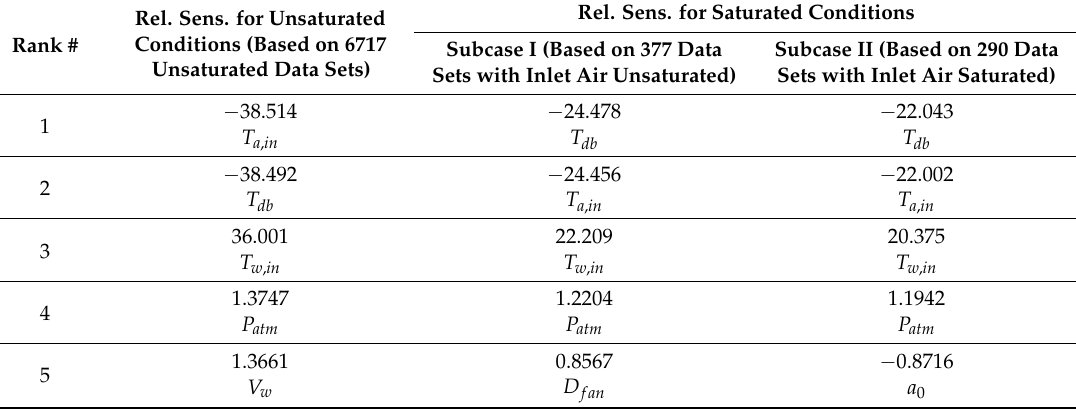
Table 11. Cross-comparison of the top five relative sensitivities for the response of air mass flow rate, m a